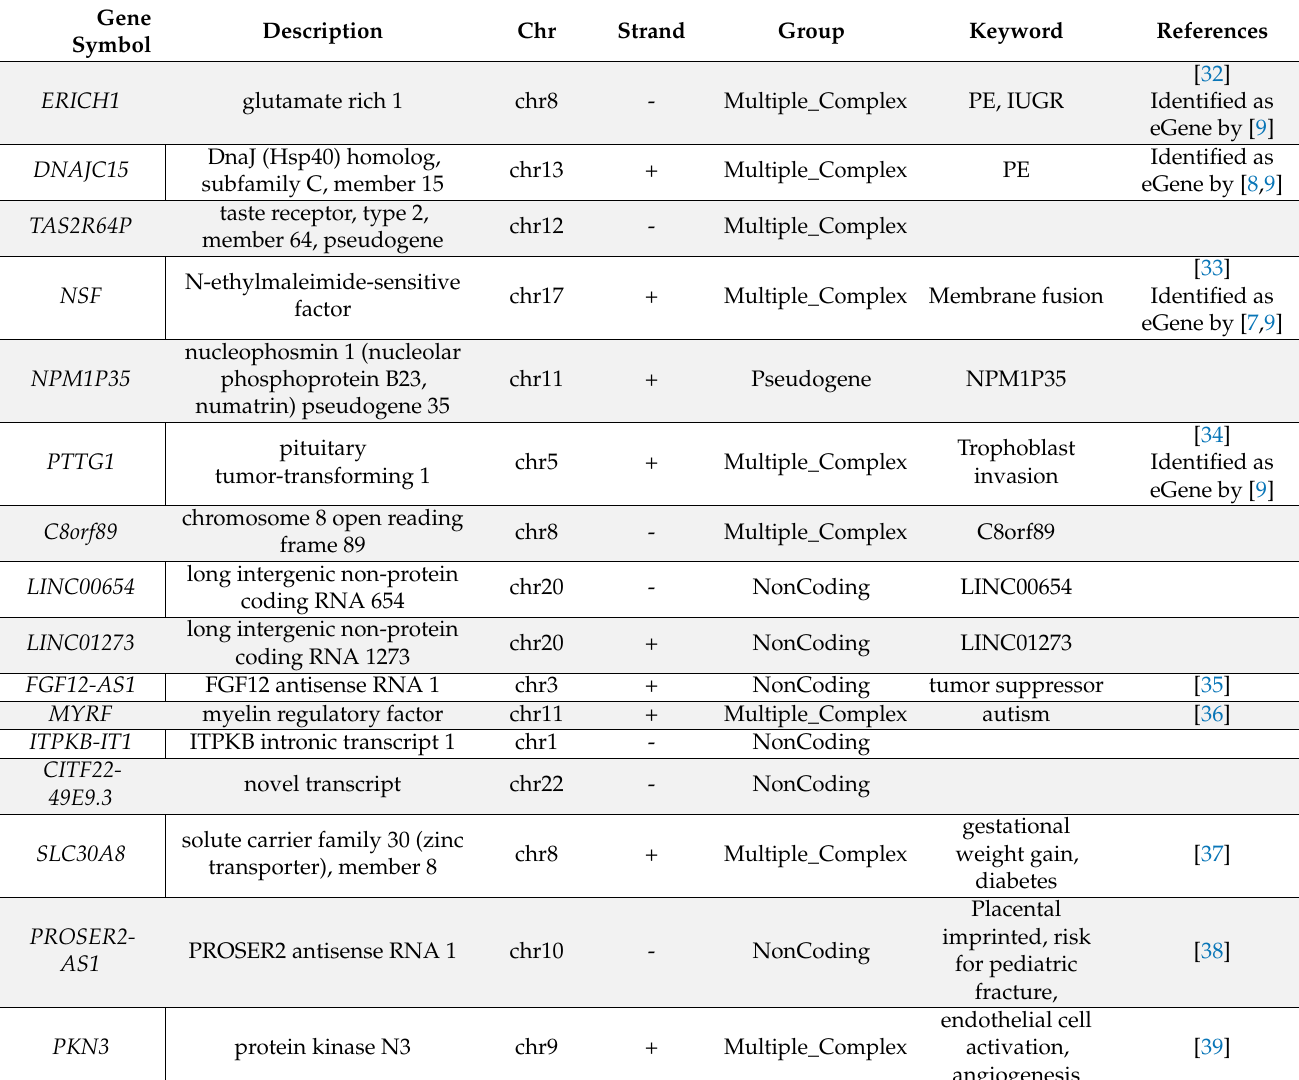
Table 3. The 16 placental disease-specific